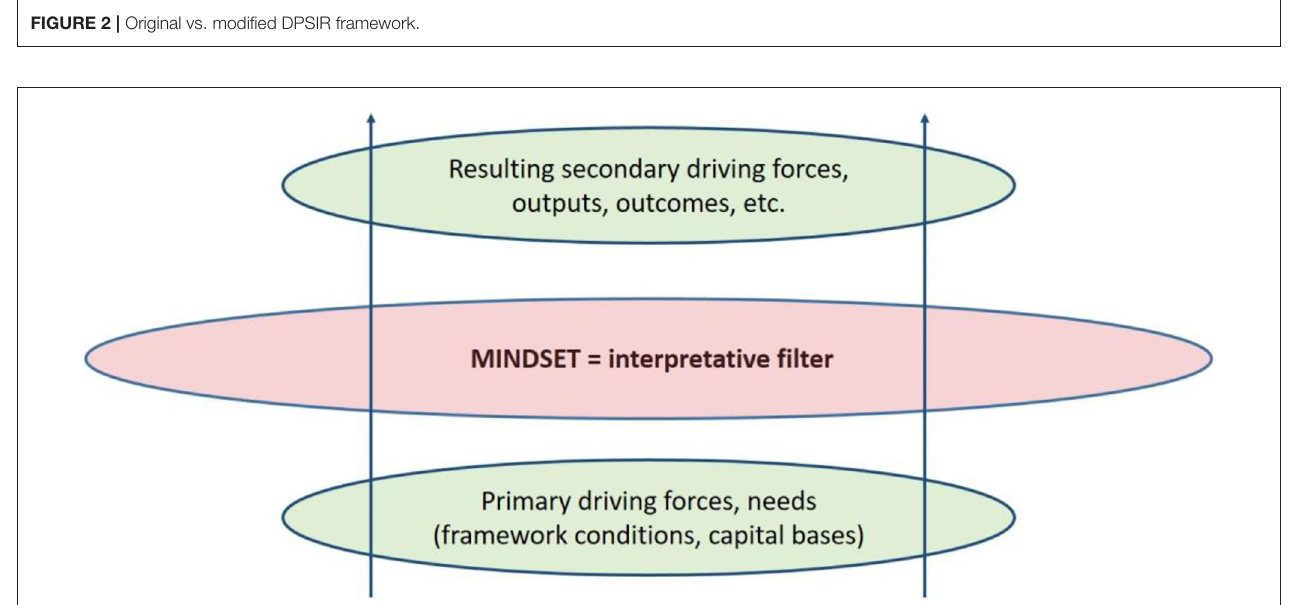
FIGURE 3 | Mindset as the mediating entity or interpretative filter between primary driving and secondary driving